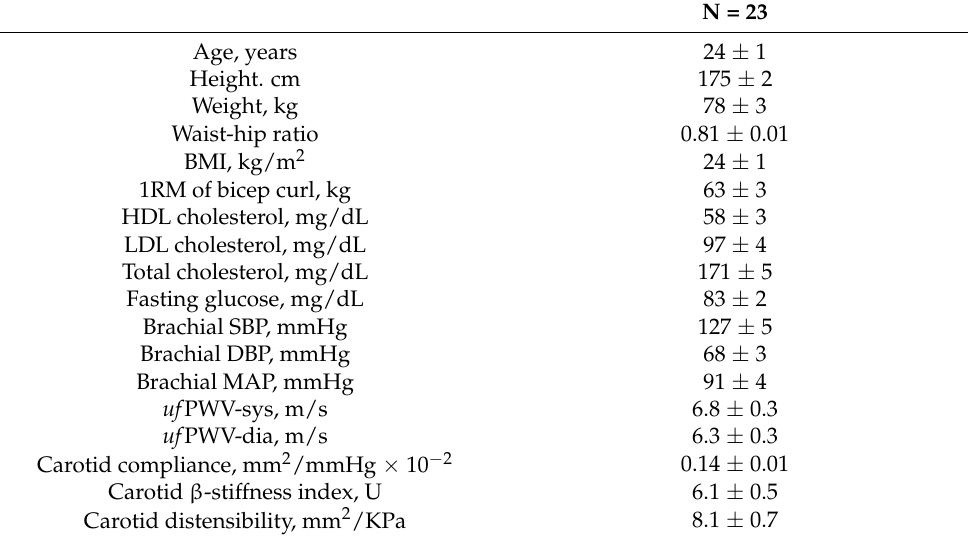
Table 1. Selected subject